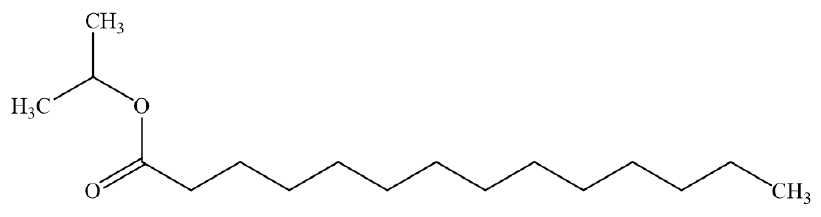
Figure 1. Chemical structure of isopropyl myristate.